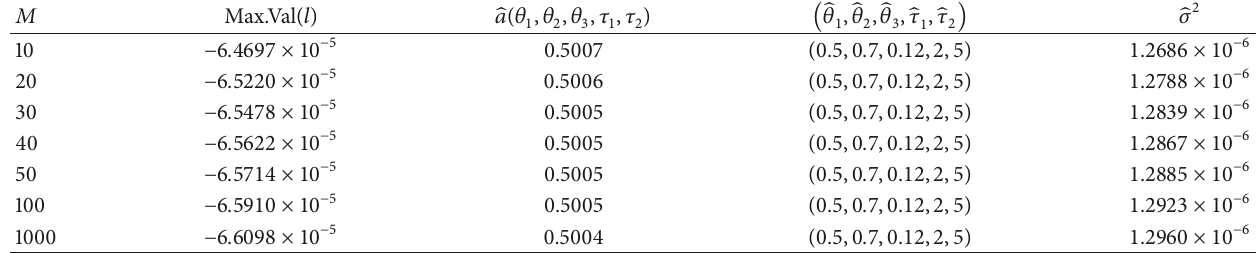
Table 7: Table showing value of Max.Val (𝑙) , ̂𝑎(𝜃 1 , 𝜃 2 ,𝜃 3 , 𝜏 1 , 𝜏 2 ) , for (𝜃 1 ,𝜃 2 , 𝜃 3 ,𝜏 1 , 𝜏 2 ) = (0.5, 0.7, 0.12, 2,5) and 𝑛 + 1 = 101 equally spaced time points in [0, 10] at ℎ = 0.1 .